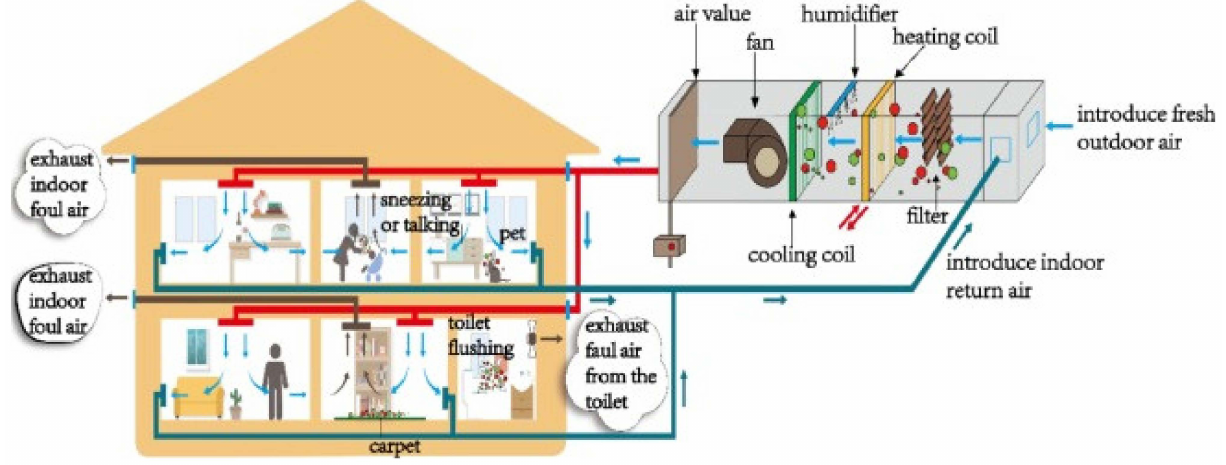
Figure 5. Schematic of microbial contamination in a HVAC system of residential buildings